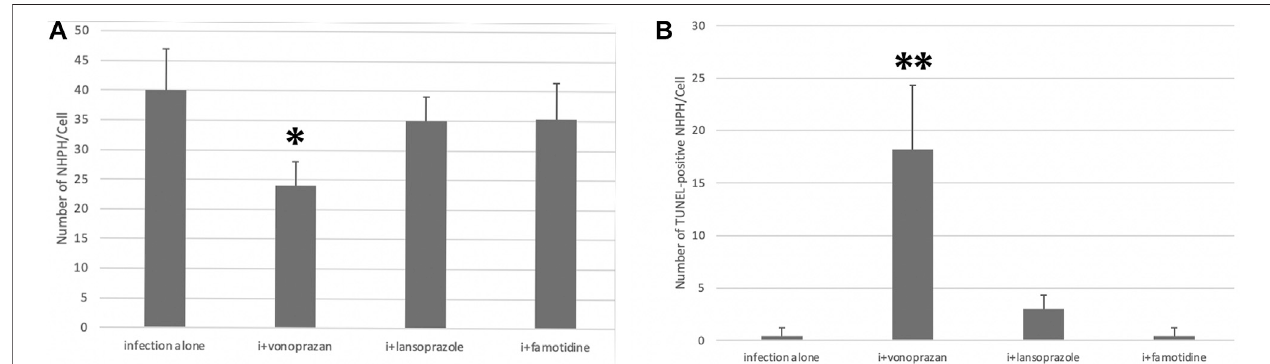
FIGURE 8 | Quantitative analysis of all NHPHs and apoptotic NHPHs by using acid suppressants by immunohistochemistry. (A) Signi fi cant difference was found betweeninfectionaloneandadministeredagentsintheNHPHnumber(F=6.14; p =0.005byone-wayANOVA). Posthoc analyses(Bonferronicorrection)revealedthat the infection-alone group is signi fi cantly larger than the infection + vonoprazan group (* p = 0.004). (B) Signi fi cant difference was found between infection alone and administered agents in the TUNEL-positive NHPH number (F = 28.1; p < 0.001 by one-way ANOVA). Post hoc analyses (Bonferroni correction) revealed that the infection + vonoprazan group is signi fi cantly larger than the infection-alone group (** p <